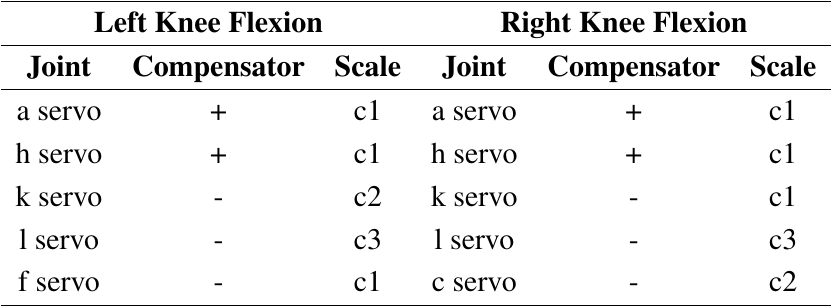
Table 1. Joints compensations for each servo motor depending on knee